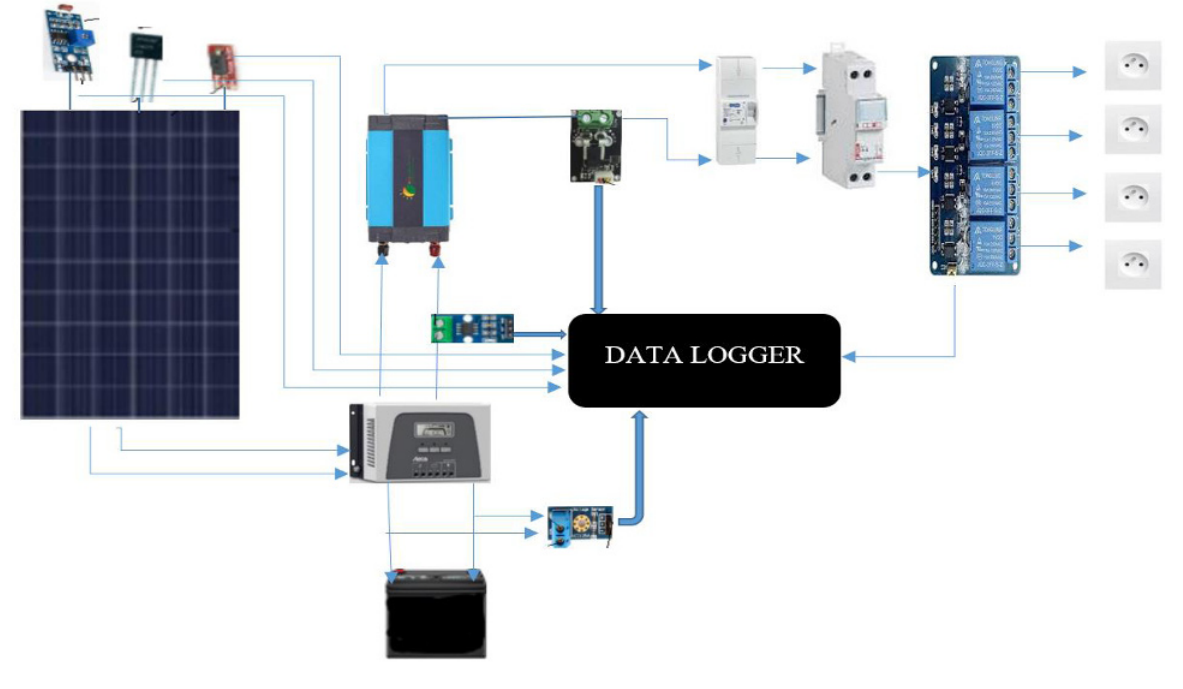
Fig. 1 Solar system equipped with DATA LOGGER